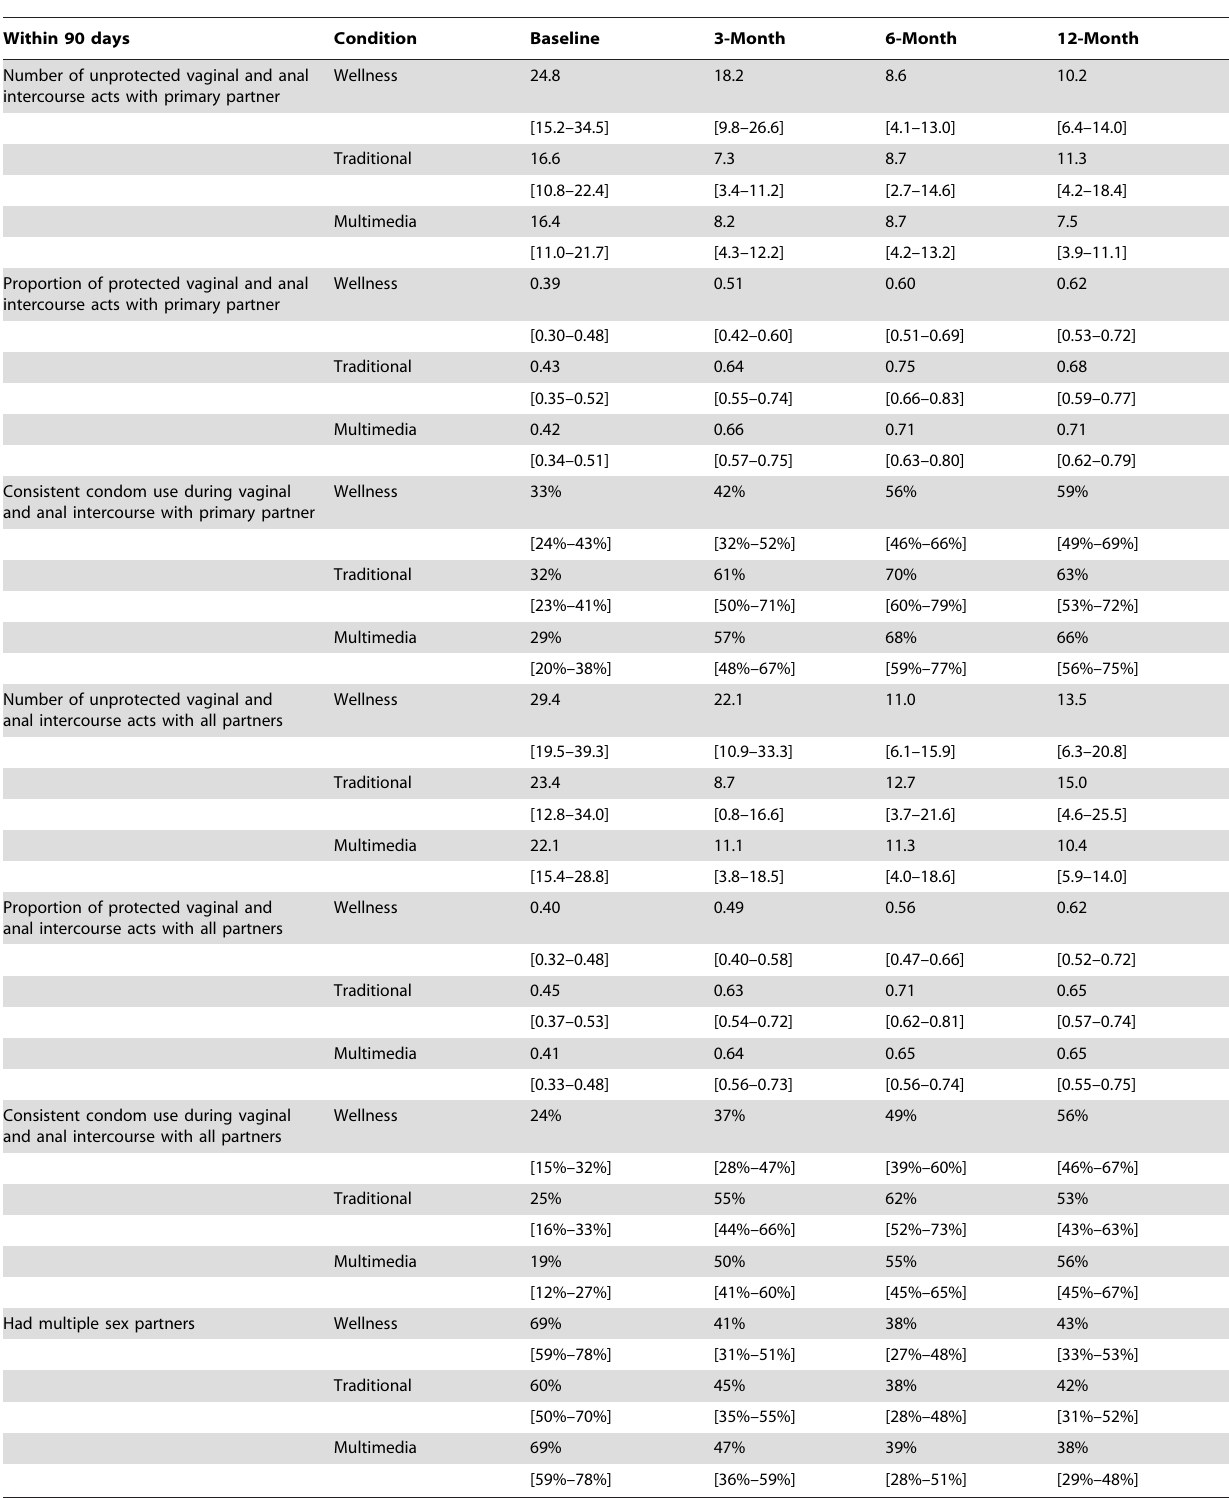
Table 2. Summary of Sexual Risk Behaviors at Baseline, 3-Month, 6-Month and 12-Month Follow-up Assessments: Means/ percentages and 95% Confidence